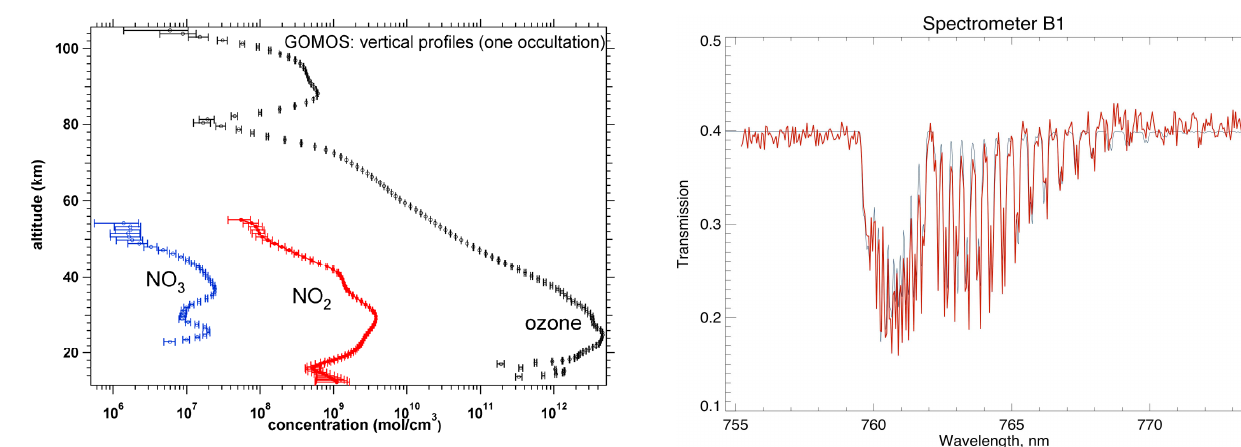
Fig. 13. Forward simulation of the atmospheric transmission. The contribution of various absorbers at a tangent altitude of 20 km are indicated as well as the total transmission. The dilution factor is due to atmospheric refraction, and is about 0.4 at 20 km altitude.